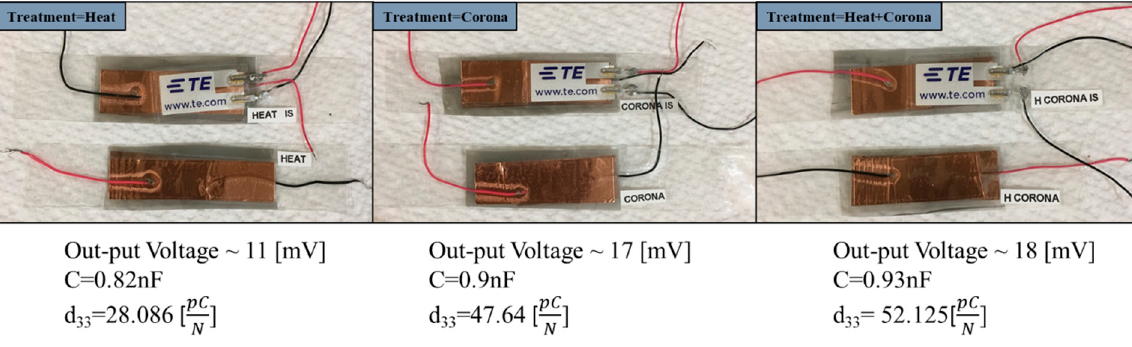
Figure 9. Voltage output, applied force, calibration constant and piezoelectric coefficient (d 33 ) evaluation.